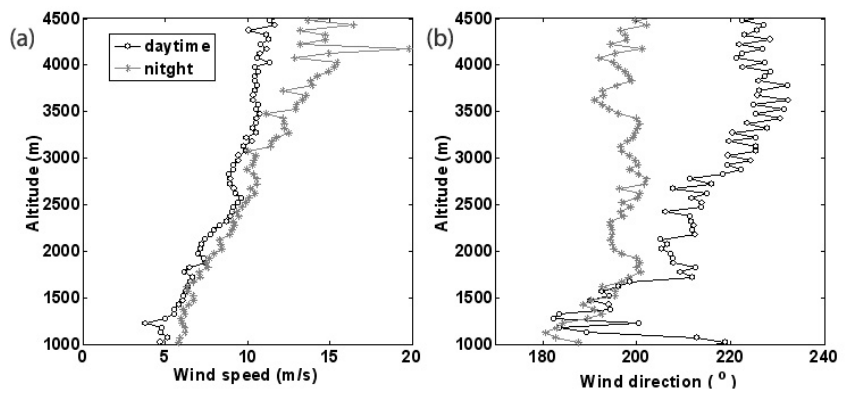
Figure 12. Mean vertical profiles of (a) wind speed (m  s -1 ) and (b) wind direction (  ), obtained Fig. 12. Mean vertical profiles of (a) wind speed (ms − 1 ) and (b) wind direction ( ◦ ), obtained with radiosondes during BEARPEX 2009 campaign with heights from 1000m to 4500m. Gray stars denote the nighttime mean values (4 profiles launched for 00:00 ∼ 03:00) and with radiosondes during BEARPEX 2009 campaign with heights from 1000 m to 4500 m. Gray white circles represent mean daytime profiles (8 profiles launched between 10:00 ∼ 17:00) during the BEARPEX campaign in stars denote the nighttime mean values (8 profiles launched between 10:00~17:00) and white circles represent mean daytime profiles (4 profiles launched for 00:00~03:00) during the BEARPEX campaign in 2009.